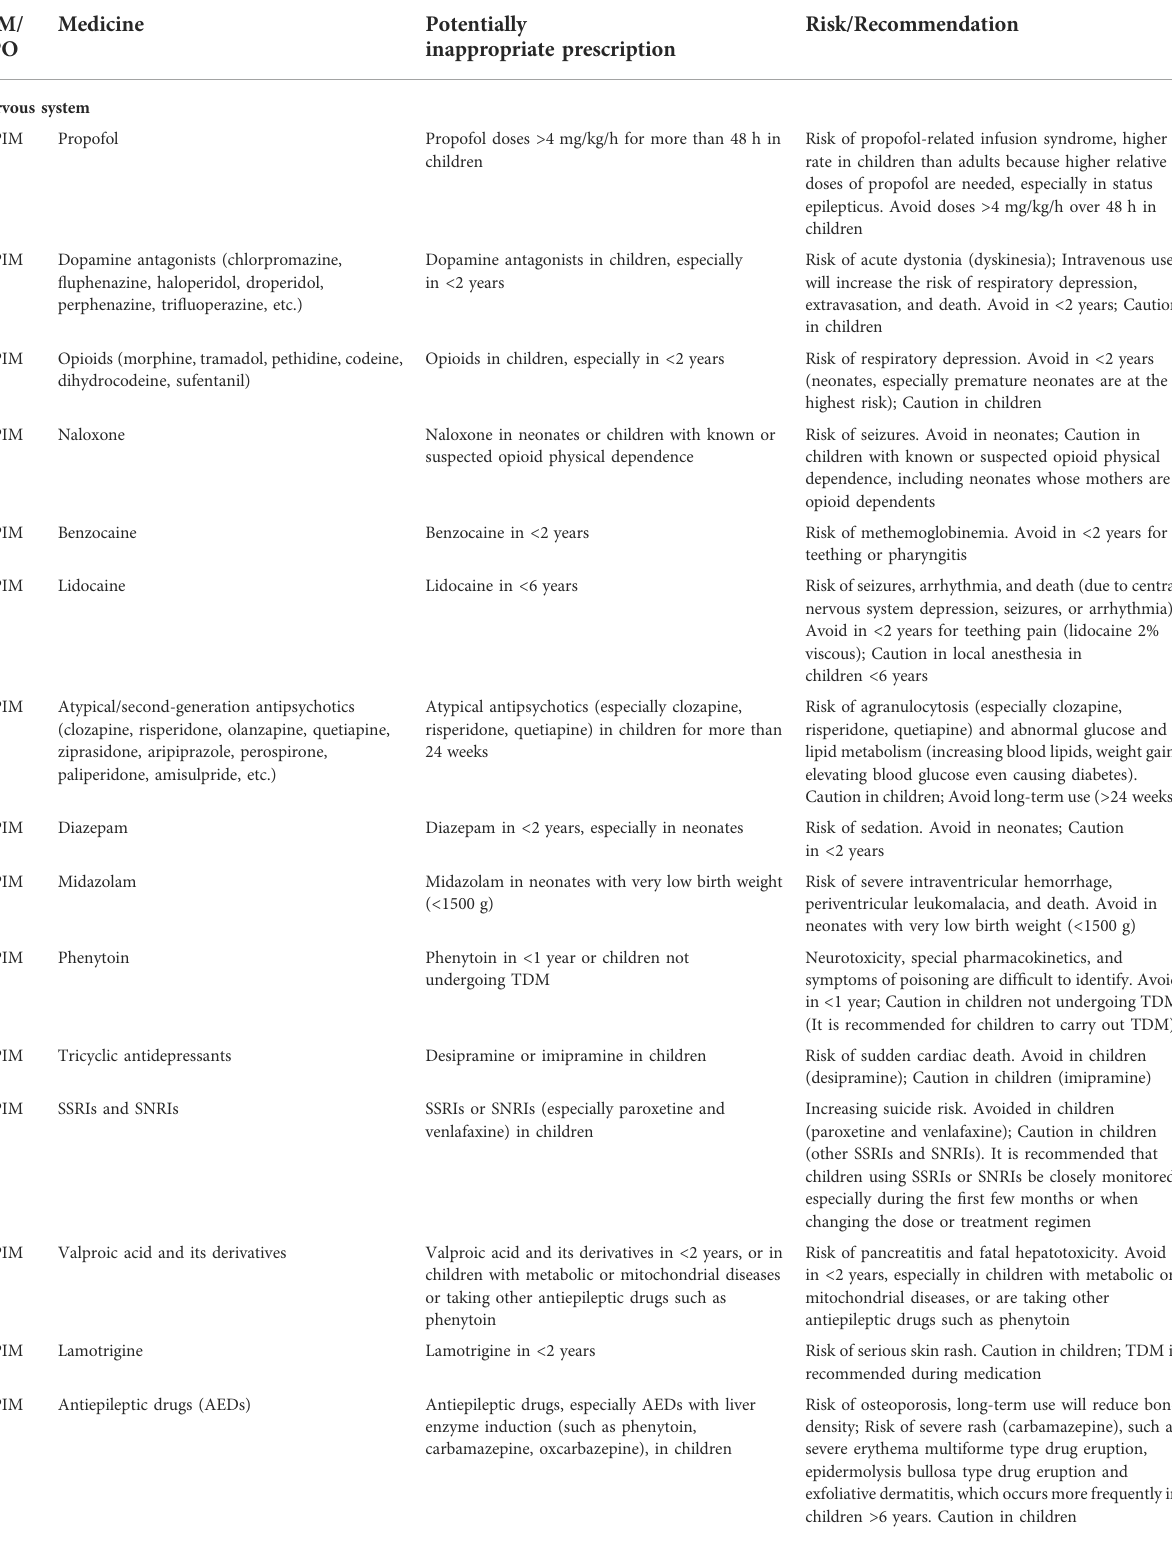
TABLE 1 PIP criteria for children with non-speci fi c